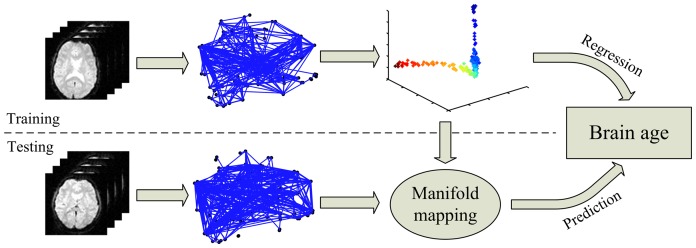
Flow chart of age prediction via rs-fcMRI.